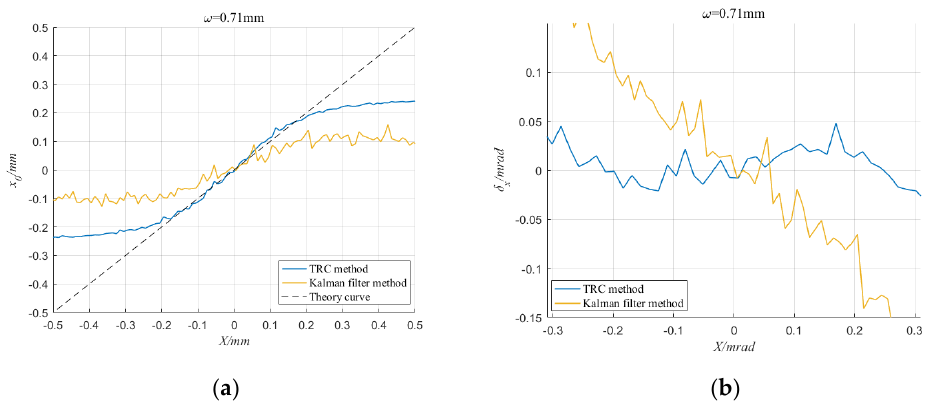
Figure 13. When ω = 0.71 mm and SNR = − 17.86 dB, detection results of TRC method and Kalman filter method. ( a ) The Calculated coordinate curve; ( b ) Absolute